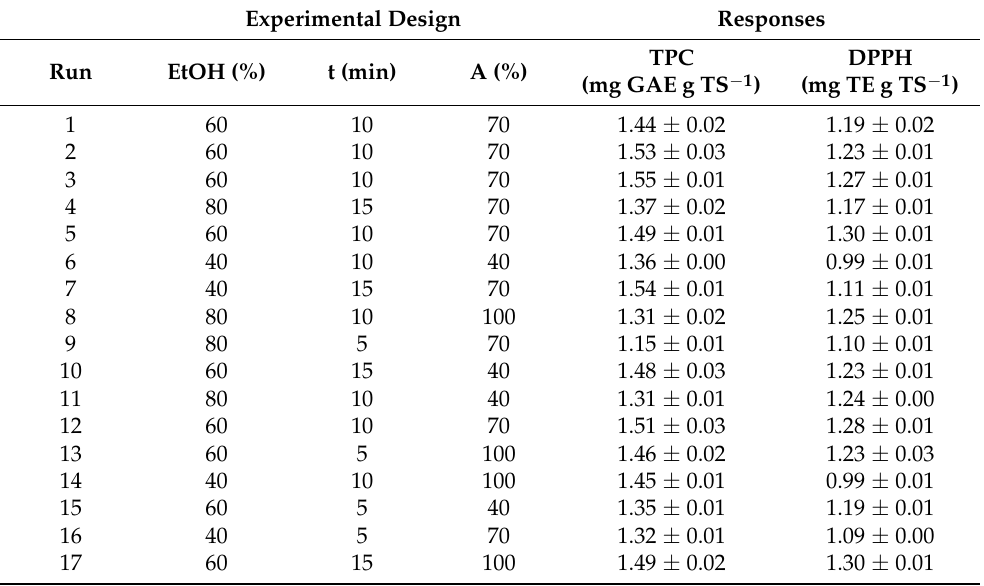
Table 2. Box–Behnken experimental design matrix and response values obtained from TS by